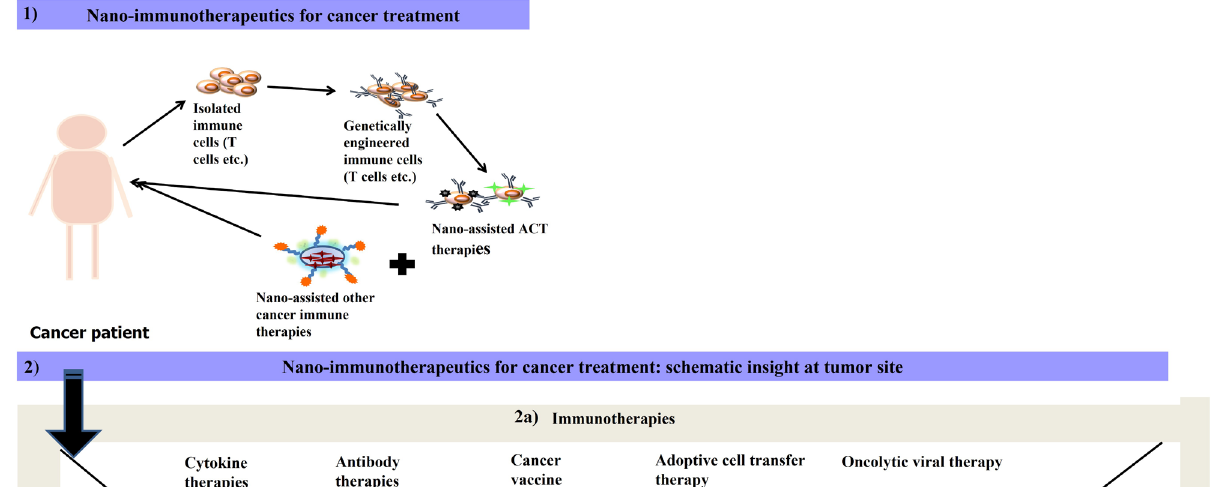
Figure 1. Schematic illustration of 1) nano-immunotherapeutics for cancer treatment in cancer patients; 2) nano-immunotherapeutics at tumor specific site where 2a) represent different types of immune therapies that are currently be employed for tumor targeting; 2b) represent nano-assisted immunotherapies applied as magnetic or photosensitized immune cell at TME, artificial nano-APCs for tumor antigen presentation and processing at TME for effective recruitment of adoptive immune cells; 2c) represent surface